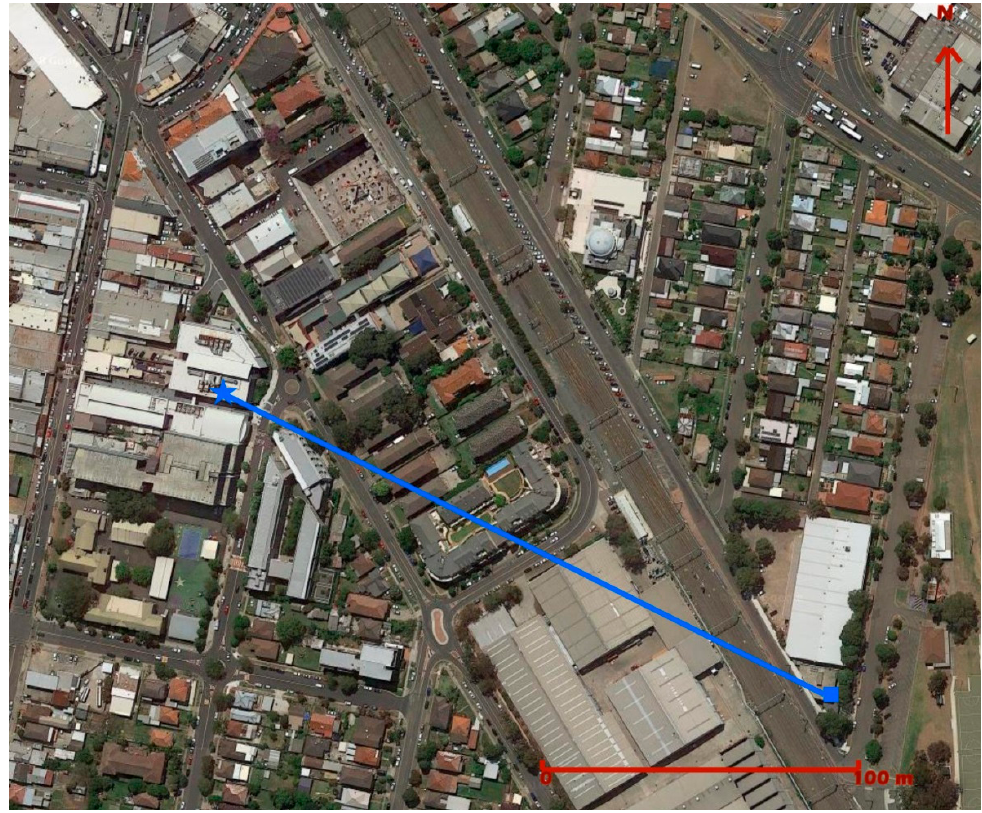
Figure 1. The measurement site at the edge of the Auburn business district. The location of the main measurement site including the open path Fourier transform infra ‐ red (OP ‐ FTIR) spectrometer location ( (cid:0) ), on roof of 2 story building and retro ‐ reflectors ( ) on roof of 3 story building at the edge of the small business district in Auburn is located. The measurement path (395 m) is marked ( ‐ ). There is a major intersection in the north ‐ east. To the east is light industrial area, with mainly residential to the east. The measurement path crosses a railway line and a major intra ‐ urban motorway is to the east (not shown on the map).